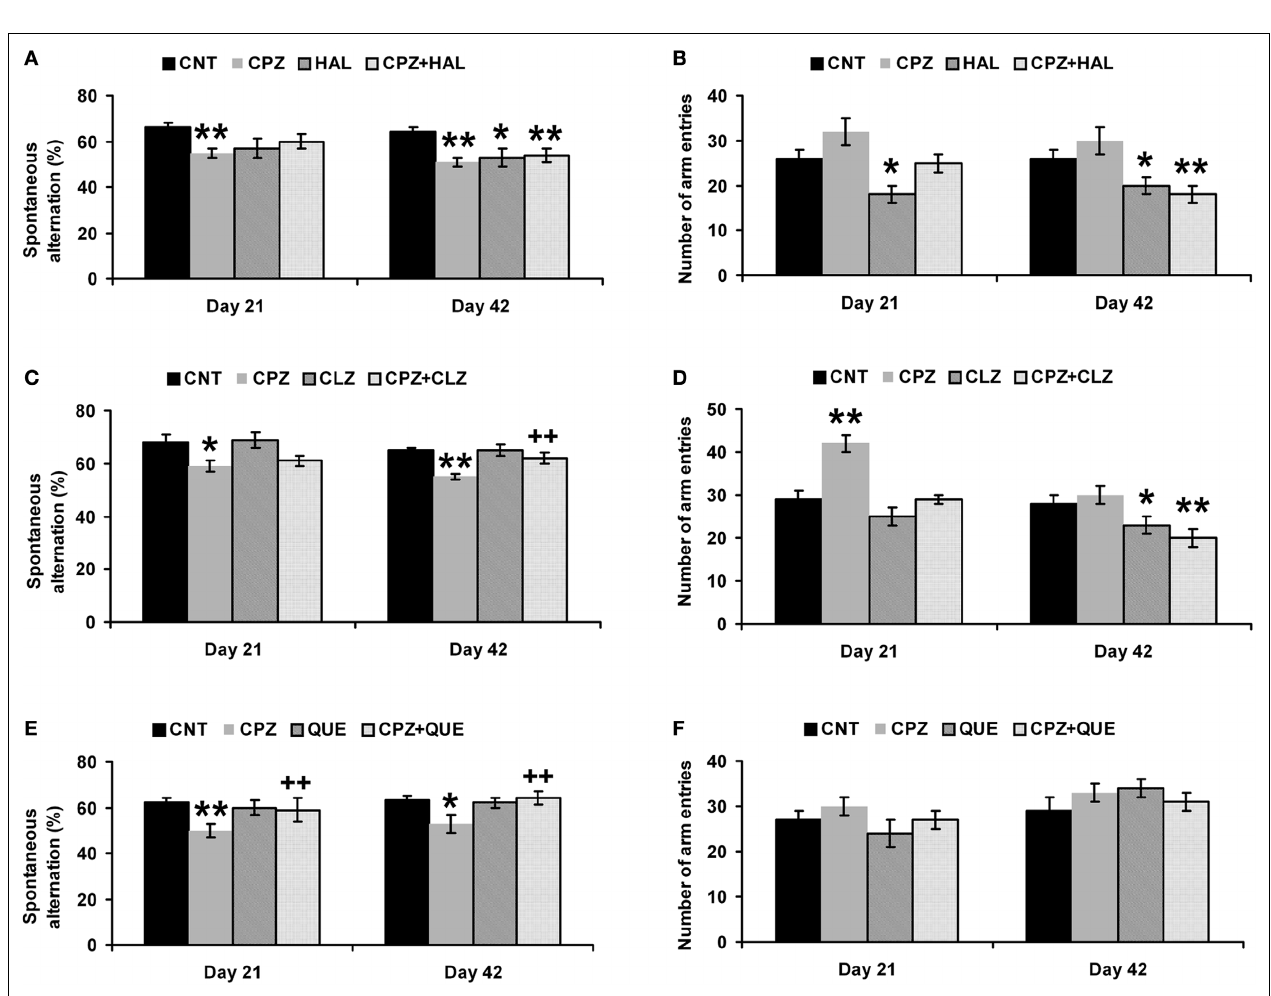
FIGURE 2 | Effects of antipsychotics on the CPZ-induced abnormal performance in the Y-maze test. Control and experimentally treated C57BL/6 mice were subjected to Y-maze test on the same days (21st and 42nd days after CPZ-exposure). (A) The data of the spontaneous alternation in the HAL experiment. (B) The data of the number of arm entries in the HAL experiment. (C) The data of